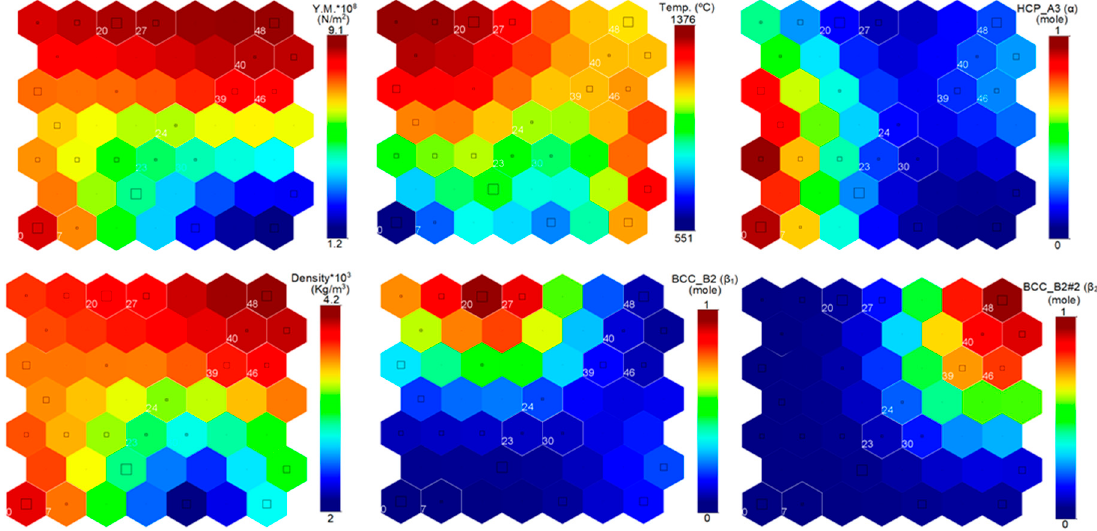
Figure 2. Correlation between desired phases, temperature, and properties.